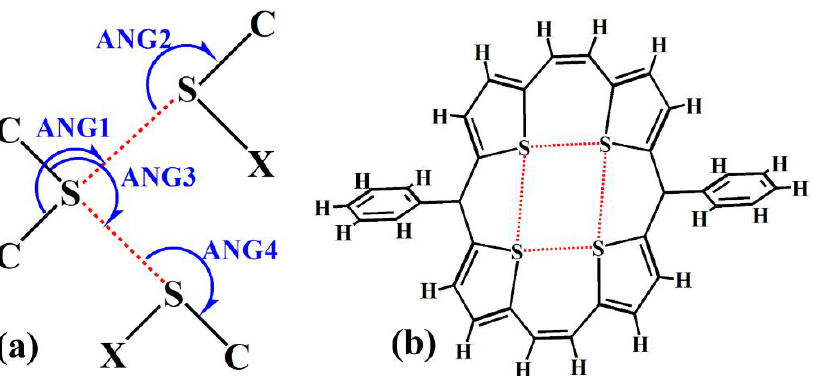
Figure 2. The schematic diagram of the intermolecular bifurcated σ -hole ··· σ -hole stacking interaction ( a ), and a typical example of the intramolecular bifurcated σ -hole ··· σ -hole stacking interactions in the crystal structure of 5,16-diphenyltetrathia[22]annulene (EJIGOU) ( b ).